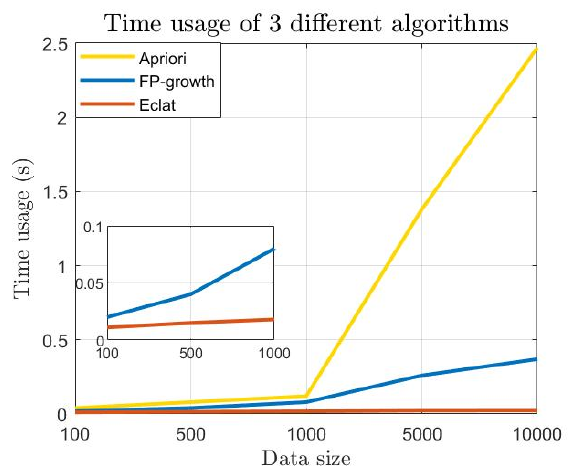
Figure 4. Time usage of the three algorithms in terms of different data sizes.